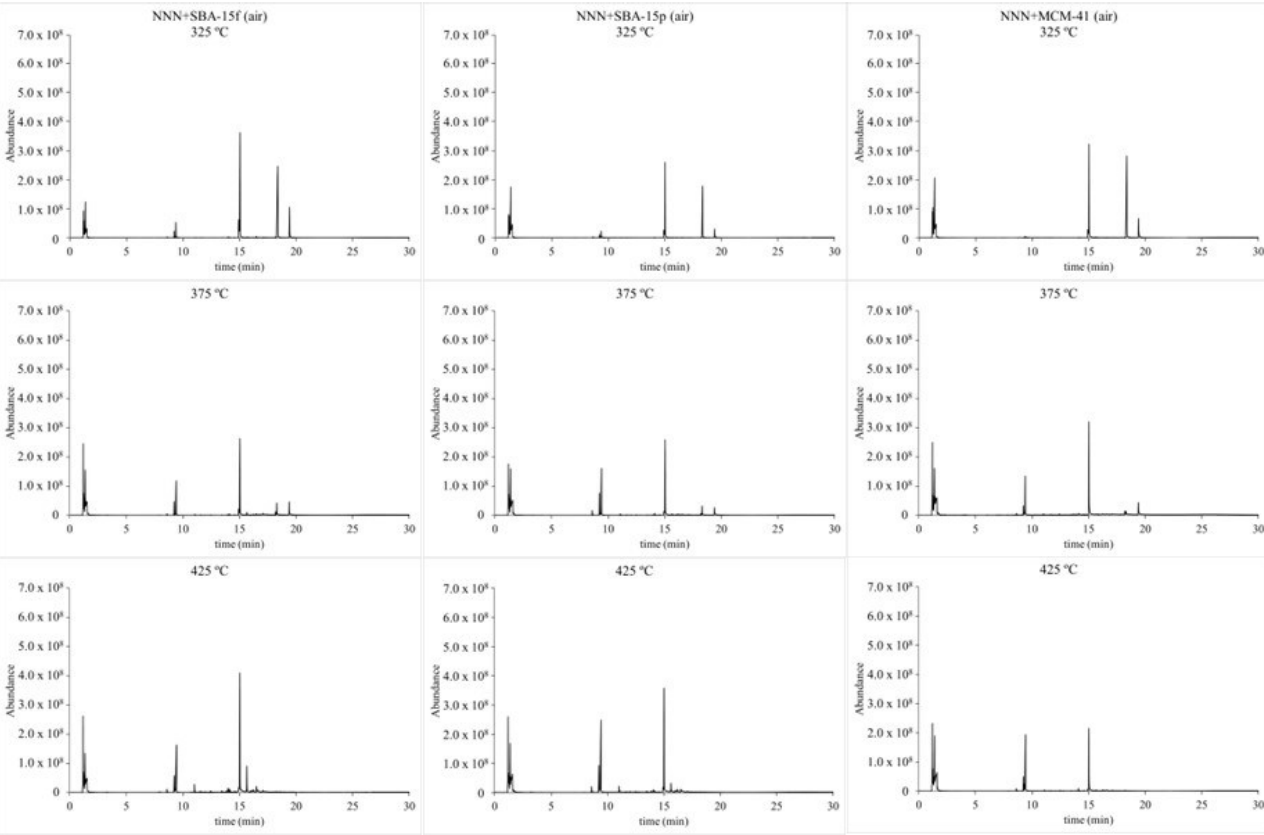
Figure 14. Chromatograms of the pyrolysis of NNN with SBA-15f (left), SBA-15p ( center ) and MCM-41 ( right ) at different temperatures, under the air atmosphere.